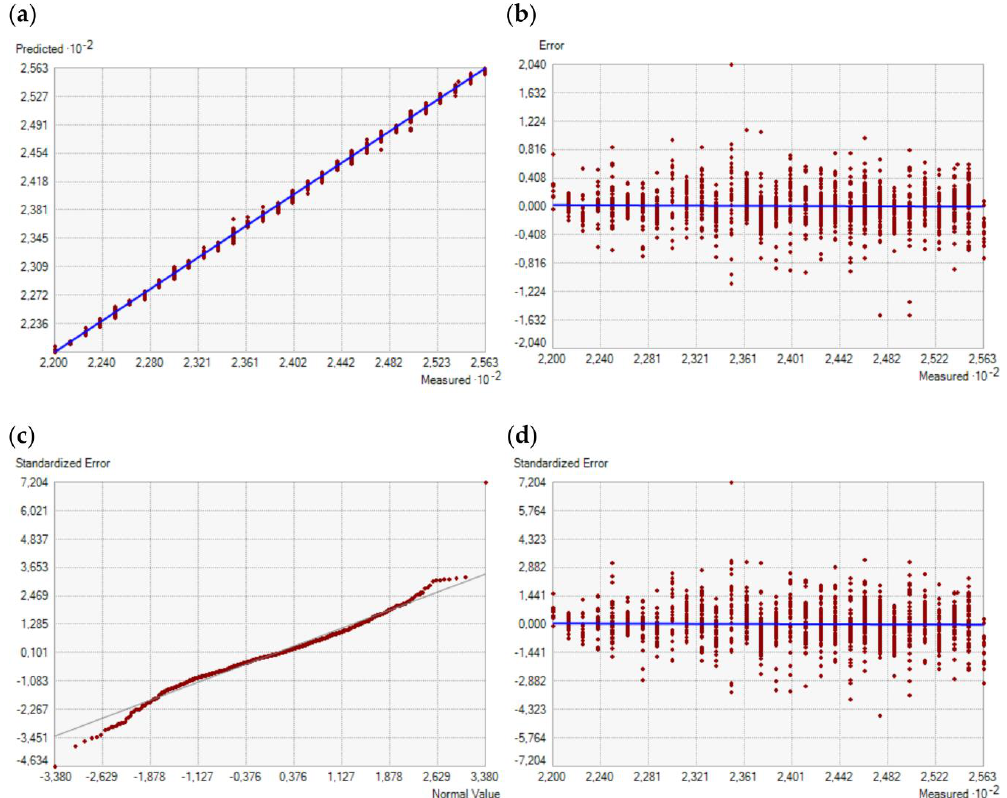
Figure 8. Graphical representation of cross-validation (CV) for the analysed dataset: ( a ) predicted value in relation to the measured value; ( b ) error (residuum) in relation to the measured value; ( c ) QQ plot presenting the standardised errors and corresponding quantiles from the standard normal distribution; ( d ) estimated kriging standard errors to the measured values.